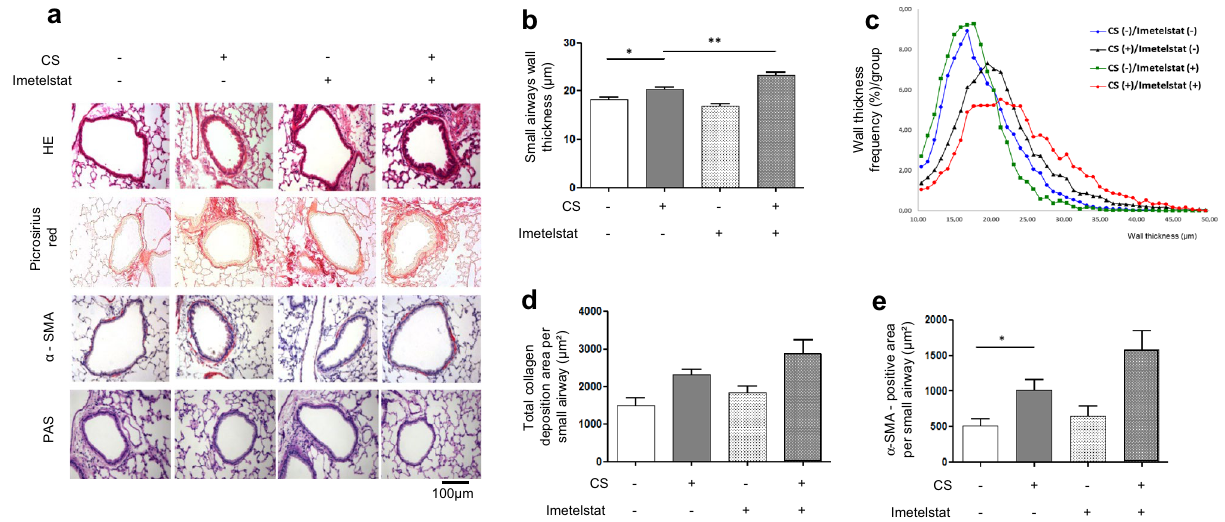
Figure 2. Imetelstat effects on cigarette smoke-induced small airway remodeling. Representative lung tissue sections of mice exposed to air or cigarette-smoke (CS) with or without Imetelstat, and stained for HE, picrosirius red, α-SMA, or PAS ( a ). Quantification of small airways wall thickness [mean in ( b ), distribution in ( c )], α-SMA expression ( d ), PAS staining ( e ). Original magnification, ×20. n = 7–8 mice per group. Data are presented as mean ± SEM. *p < 0.05, **p < 0.01.